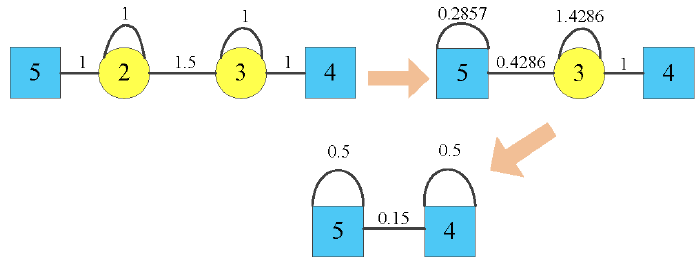
Figure 7. IEEE 5-bus system reduction process with proposed node ordering optimization.